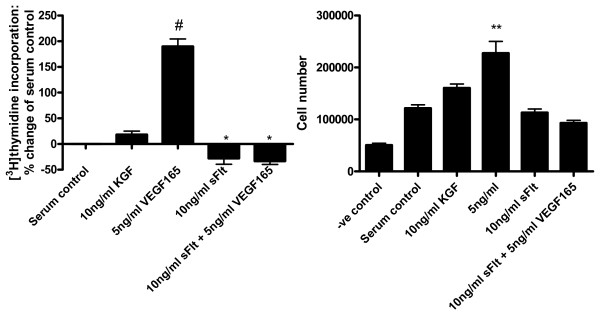
Bar graphs depicting 3H-thymidine incorporation into ATII cells (A) and cell number (B) following treatment for 48 hours with VEGF 5 ng/ml, sflt 10 ng/ml and combination confirming a significant proliferation with VEGF 5 ng/ml (#p < 0.001 vs serum control). The presence of sflt not only inhibited the proliferative effect of VEGF but also reduced proliferation below that of serum controls (*p < 0.05), suggesting an autocrine effect. Cell number also increased significantly with 5 ng/ml VEGF165 (**p < 0.01) compared to serum control. The addition of sflt alone and in combination with VEGF165 showed no significant difference compared to serum control (p > 0.05) but did significantly inhibit VEGF165-induced proliferation (p < 0.001 compared to 5 ng/ml VEGF165).